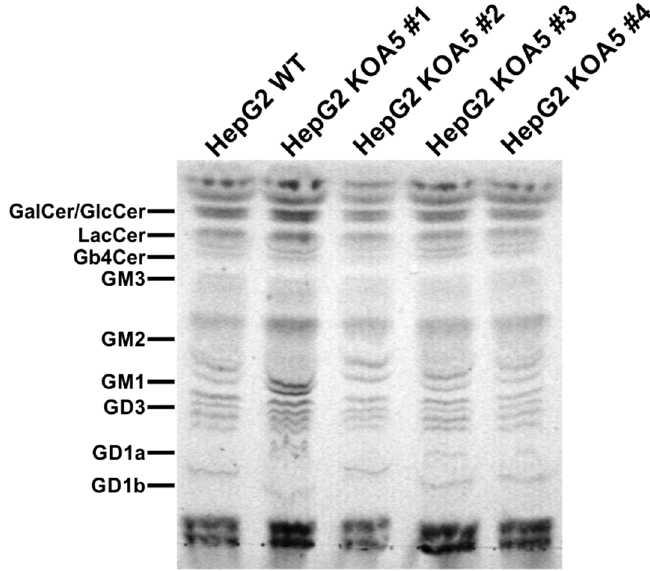
Figure 3. Analysis of glycolipids synthesized by wild-type and SLC35A5-deficient HepG2 cells. Isolated glycolipids were separated using thin-layer chromatography (TLC) and visualized with orcin/H 2 SO 4 reagent. As a control, a mixture of different glycolipids was also resolved (left line) to ensure that TLC conditions were suitable to separate a diverse range of glycolipids.